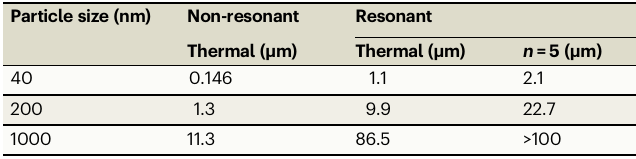
Table 1 | Comparison of the wireless trapping radii for non- resonant and resonant mode operation Particle size (nm)